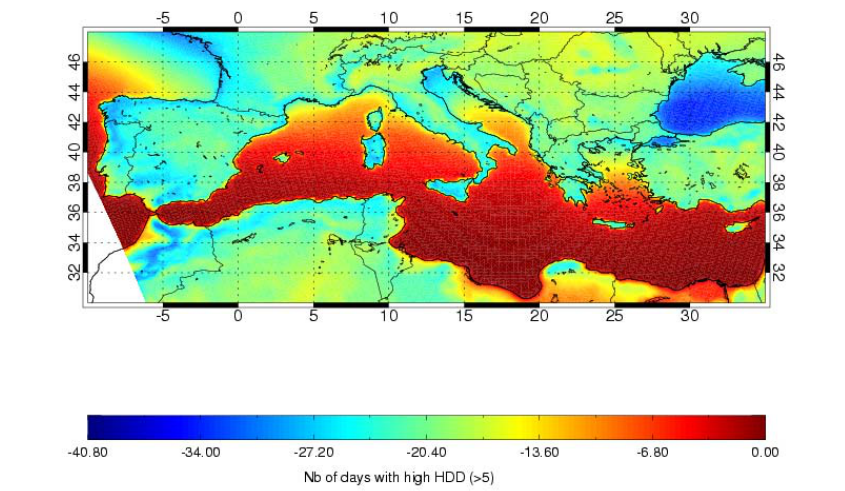
Figure 6. Changes in the number of days with high HDD (HDD > 5) between future and control period (top) and standard deviation of the changes